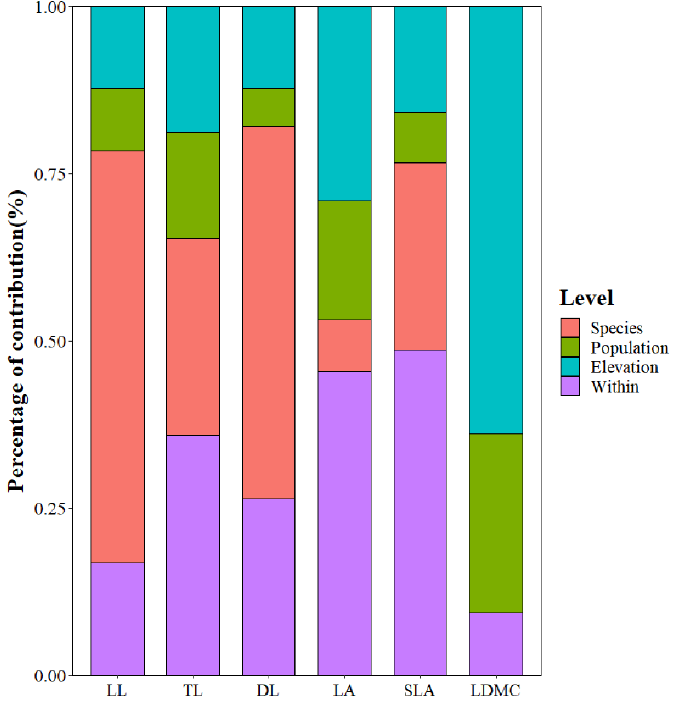
Figure 3. Variance partitioning of needle traits at different levels and between species across geo- graphic populations. Abbreviations: LL, leaf length; TL, leaf width; DL, leaf thickness; LA, leaf area; SLA, specific leaf area; LDMC, leaf dry matter content.